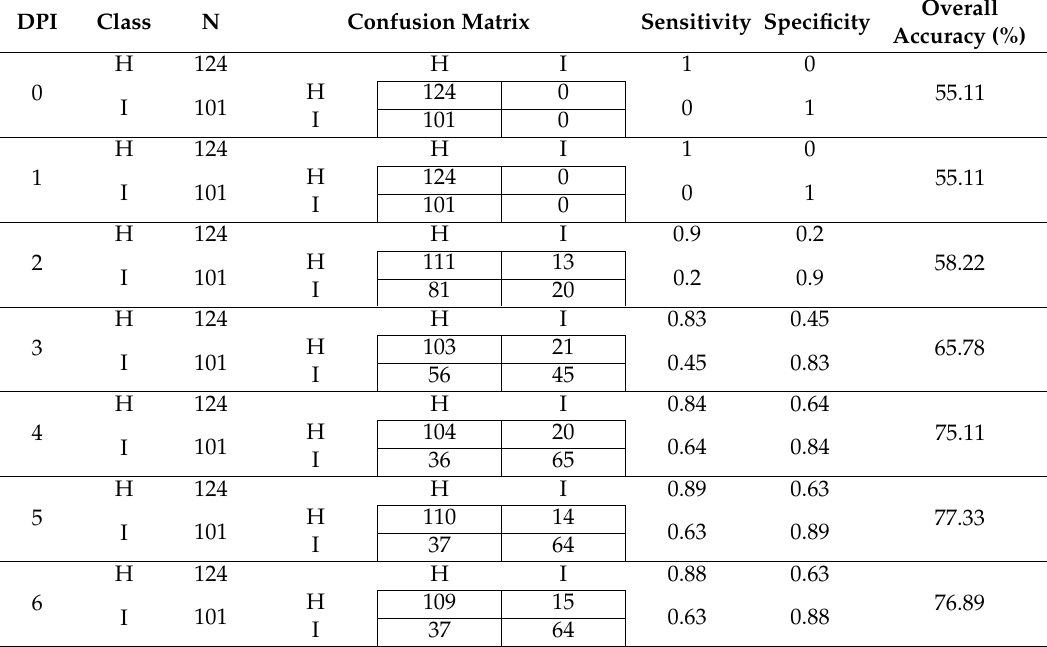
Table 3. Confusion matrix and related statistics when a linear Support Vector Machine (SVM) classifier is applied to the red-well point (RWP) wavelength to classify 124 healthy and 101 infected leaves as a function of the number of days post-inoculation (DPI).